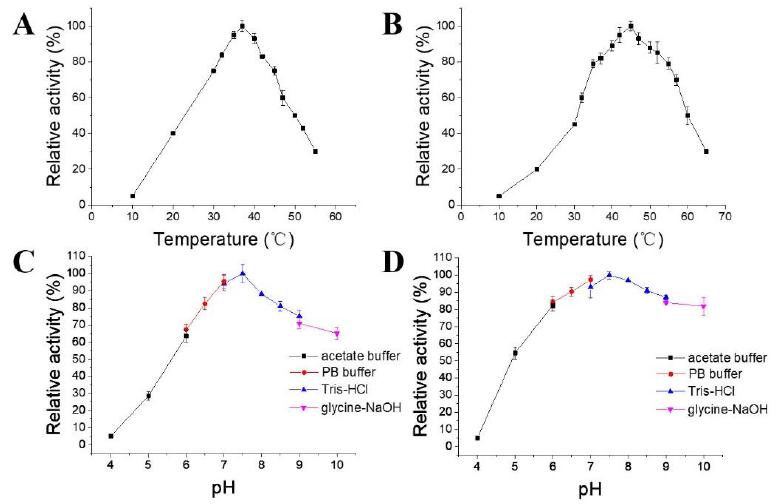
Figure 3. Activity of ECA and its mutation D60W/L211R/L310F at different temperatures and pH. ( A , B ) Activity of ECA ( A ) and its mutation D60W/L211R/L310F (B) at different temperatures. ( C , D ): Activity of ECA ( C ) and its mutation D60W/L211R/L310F ( D ) at different